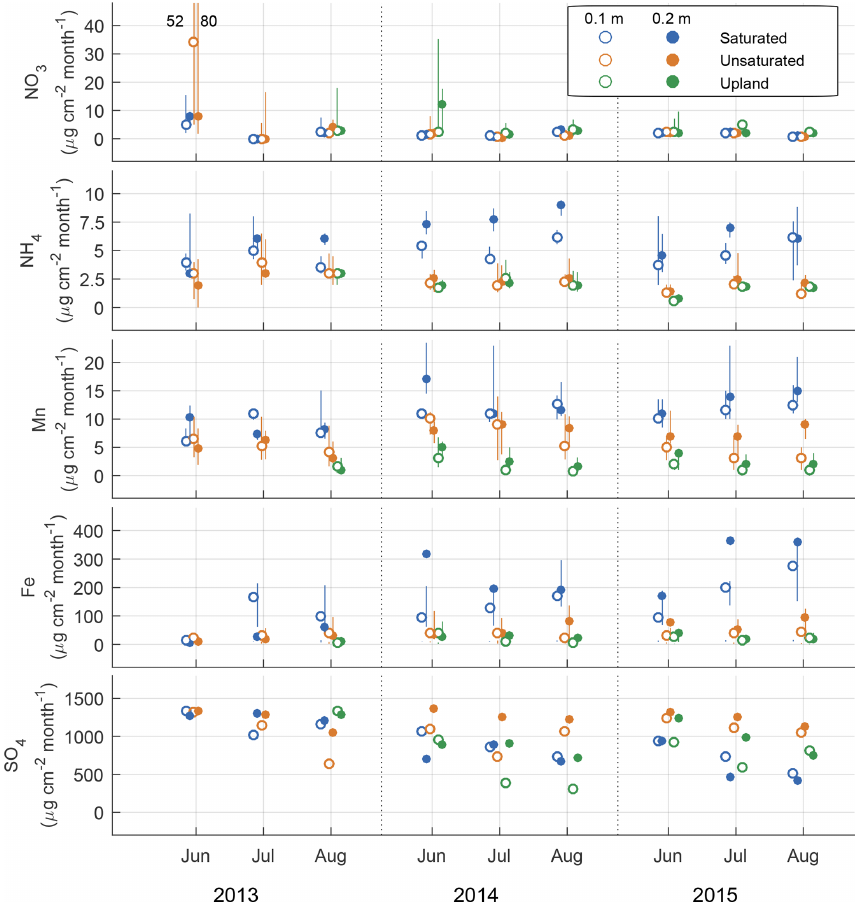
Figure 4. Ion availability as measured using plant root simulator ion exchange resins over the three monthly burial periods for 3 years expressed in units of µg10cm − 2 per month at two depths (0.1 and 0.2m). Units are a function of time the probes were buried for. Metal ions were measured in their reduced forms and mobile S is the oxidized form of sulfur. An offset has been added between groups on the x axis to reduce overlapping points. Table 3. Results of the linear mixed-effect models for CH 4 emissions, PRS ions, and REDOX potential (Eqs. 1 and 2) measured August 2015 at the nine plots along the moisture gradient in the lowland of the Sandhill Fen Watershed. Values are the mean effect ± the standard deviation. Bold values indicate parameters significantly different from zero at the α = 0 . 05 level. Vegetation effects are only for the CH 4 emission model (Eq. 1). Plot effect is the standard deviation of the random effects from each